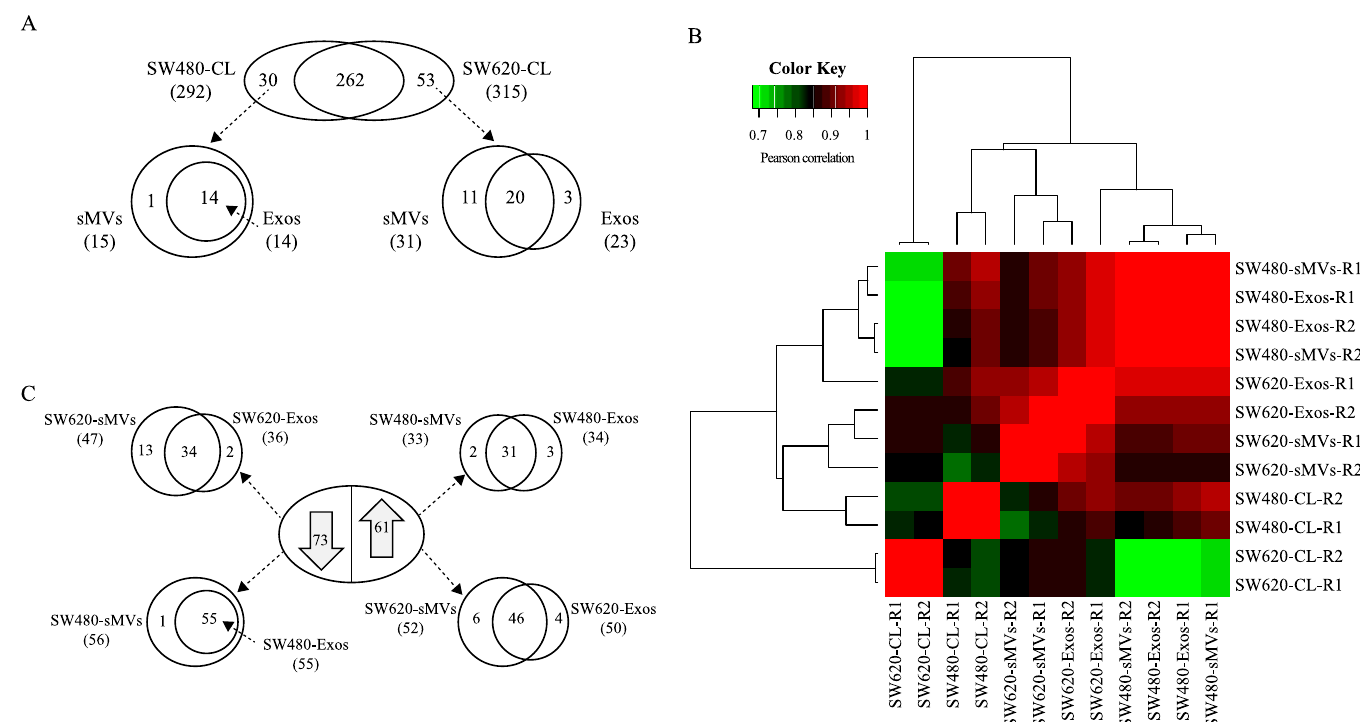
Fig 2. Analysis of cellular miRNAs in human colon cancer cell models. A , Venn diagrams of miRNAs identified in SW480/ SW620 cell lysates (biological replicates combined) and for each cell line the number of unique miRNAs that selectively distribute to secreted EVs: sMVs and Exos. B , Correlation coefficient heat map shows limited variability between biological replicates (R1-2) and illustrates differences between miRNA profiles of SW480/SW620-CLs and their secreted EV subtypes. C , Differential miRNA expression analysis (log 2 FC > 1 or < -1, p-value < 0.05, FDR < 0.05) in SW480/SW620 cell lines by edgeR revealed 134 dysregulated miRNAs (S2 Table). Of these, 73 are miRNAs down-regulated in SW620-CL and 61 up-regulated, relative to SW480-CL; the Venn diagrams show the number of dysregulated miRNAs that selectively distribute to SW480/SW620 secreted EVs.